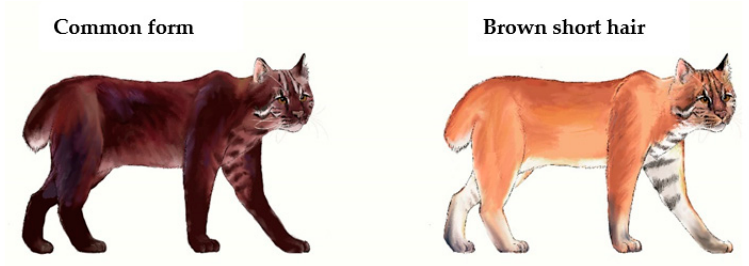
Figure 4. Broken tail phenomenon in common and brown short-haired forms.